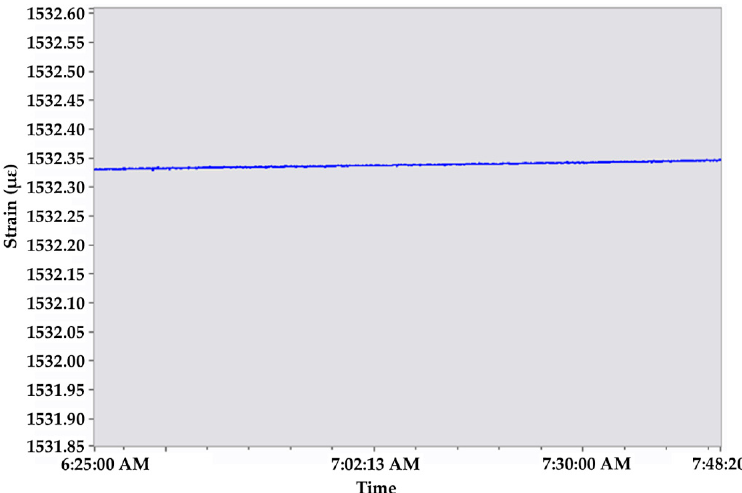
Figure 5. Fiber Bragg grating data captured during fixture testing. Units on the vertical axis are in microstrain, and the horizontal axis is time.